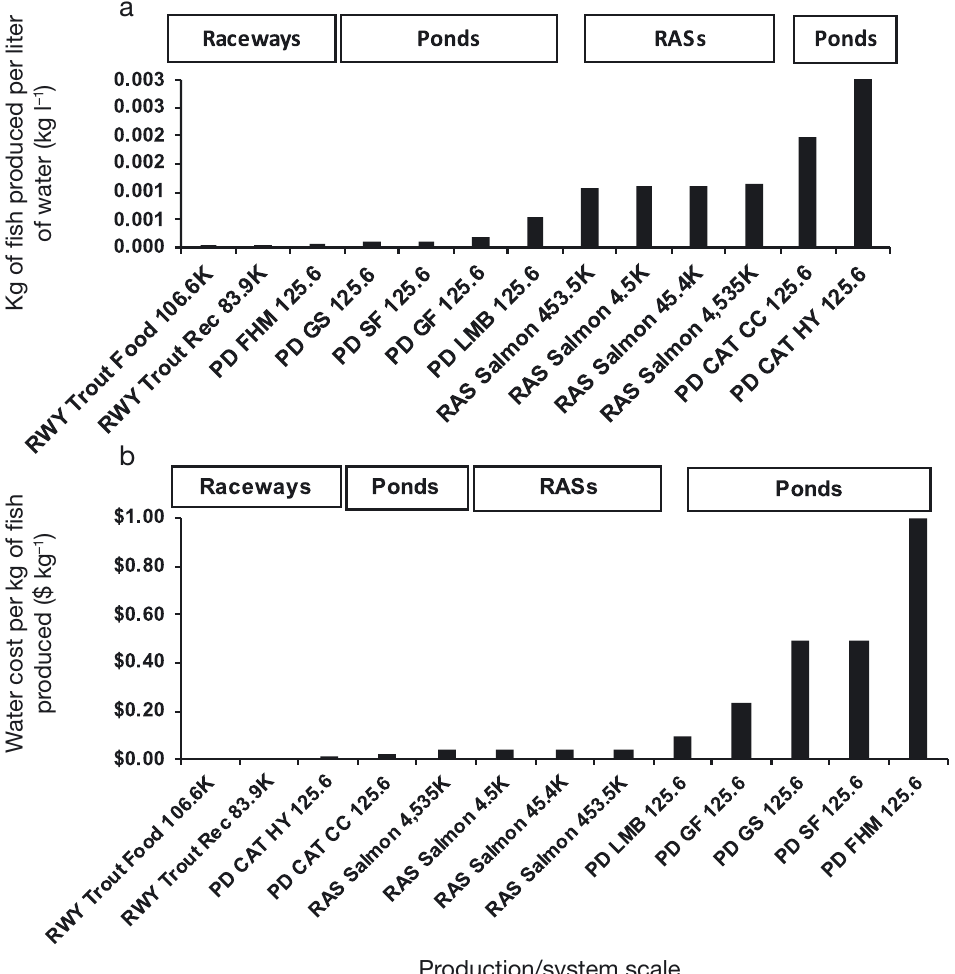
Fig. 2. (a) Water productivity and (b) water cost across production systems. In scenarios where production scale did not affect relative rankings, only one production scale is presented. Abbreviations as in Fig.